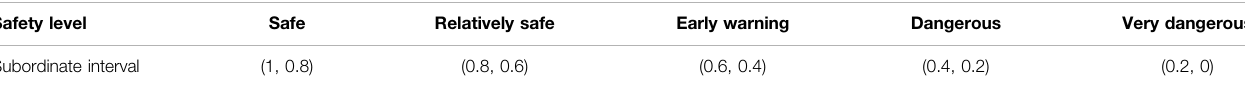
TABLE 4 | Division of the deep foundation pit safety grade interval.